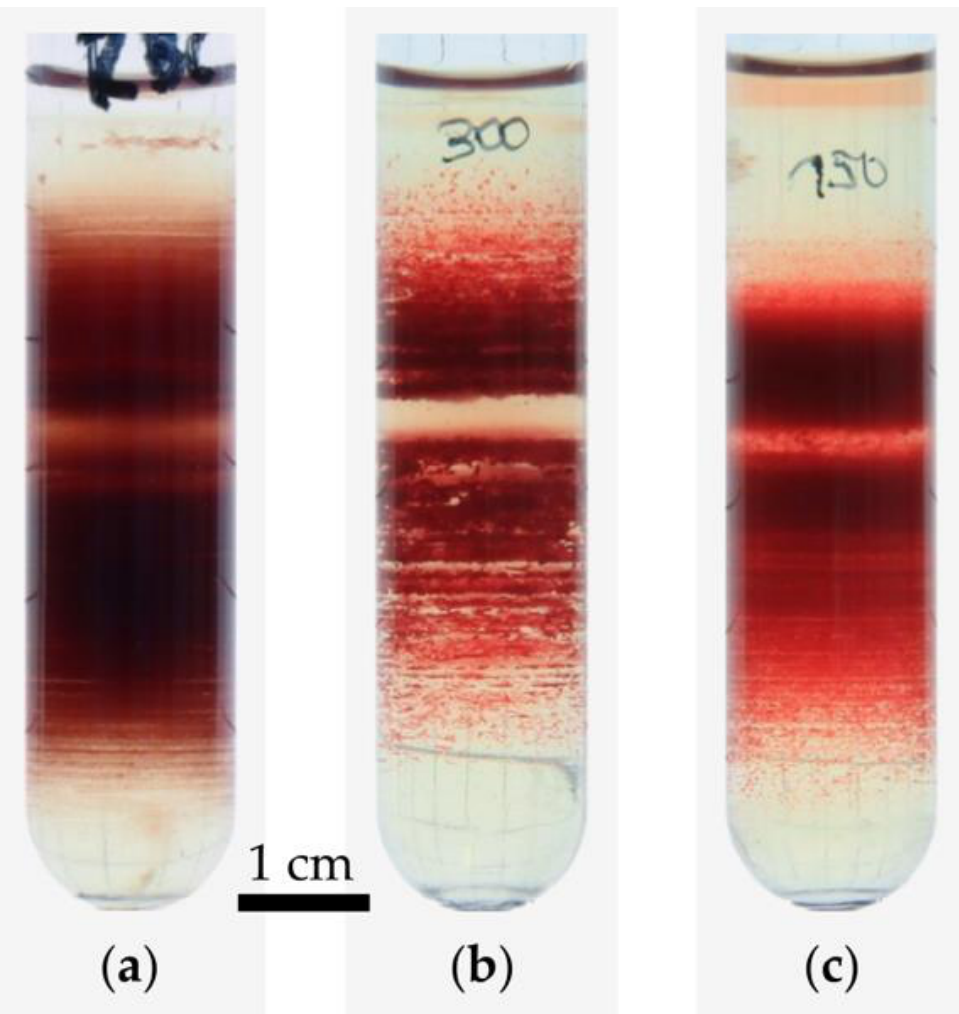
Figure 7. Suppressing aggregation. ( a ) Isotonic RBCs fixed with GA; ( b ) an isotonic control sample; ( c ) a hypotonic sample of 150 mosmol/kg H 2 O; the density medium was adjusted to account for hydration-related changes in cell density, centrifugation conditions were 25 °C , 20,000 × 𝑔 , 20 min in a Hermle Z36 HK . EDTA was used as the anticoagulant at blood withdrawal.